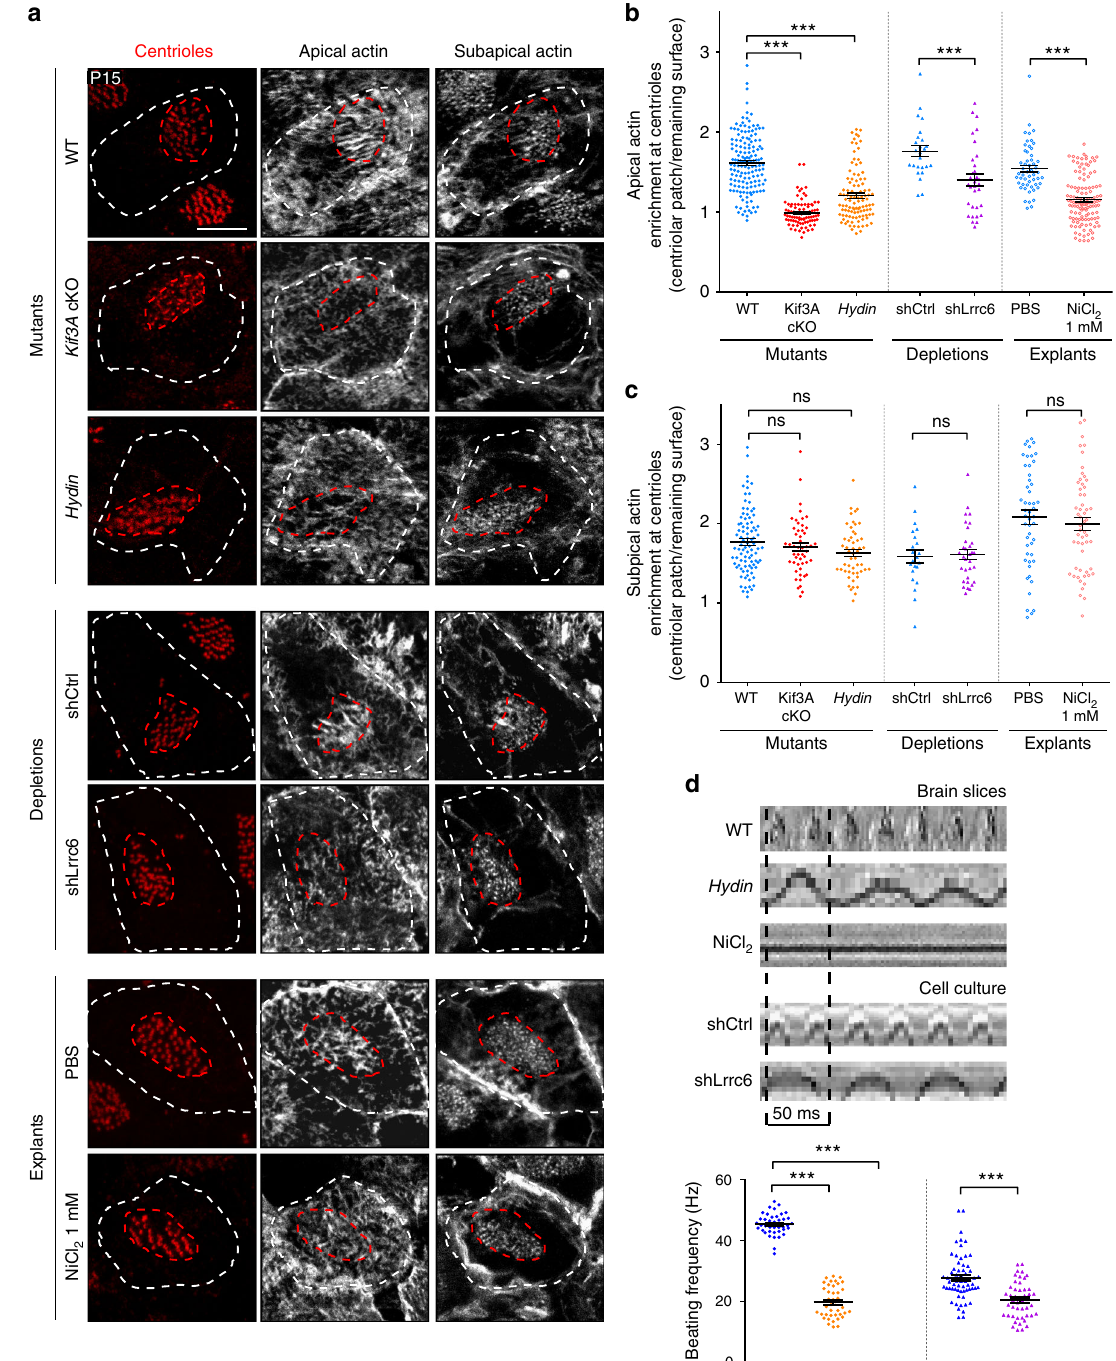
(Supplementary Figure 1a, c). Line scans (kymograms) and quanti fi cation of cilia beating frequency on side views of videos of motile cilia showed that the beating frequency was reduced in hydin mutant mice (Fig. 2d) and its amplitude abnormal (Supplementary Figure 1d), con fi rming that hydin mutant cilia are stiff and beat slowly 31 . F-actin immunostaining in mature ependymal cells in hydin mutants showed that the subapical actin network organisation was unchanged compared to control cells (Fig. 2a, c), but the apical actin enrichment in the centriolar patch